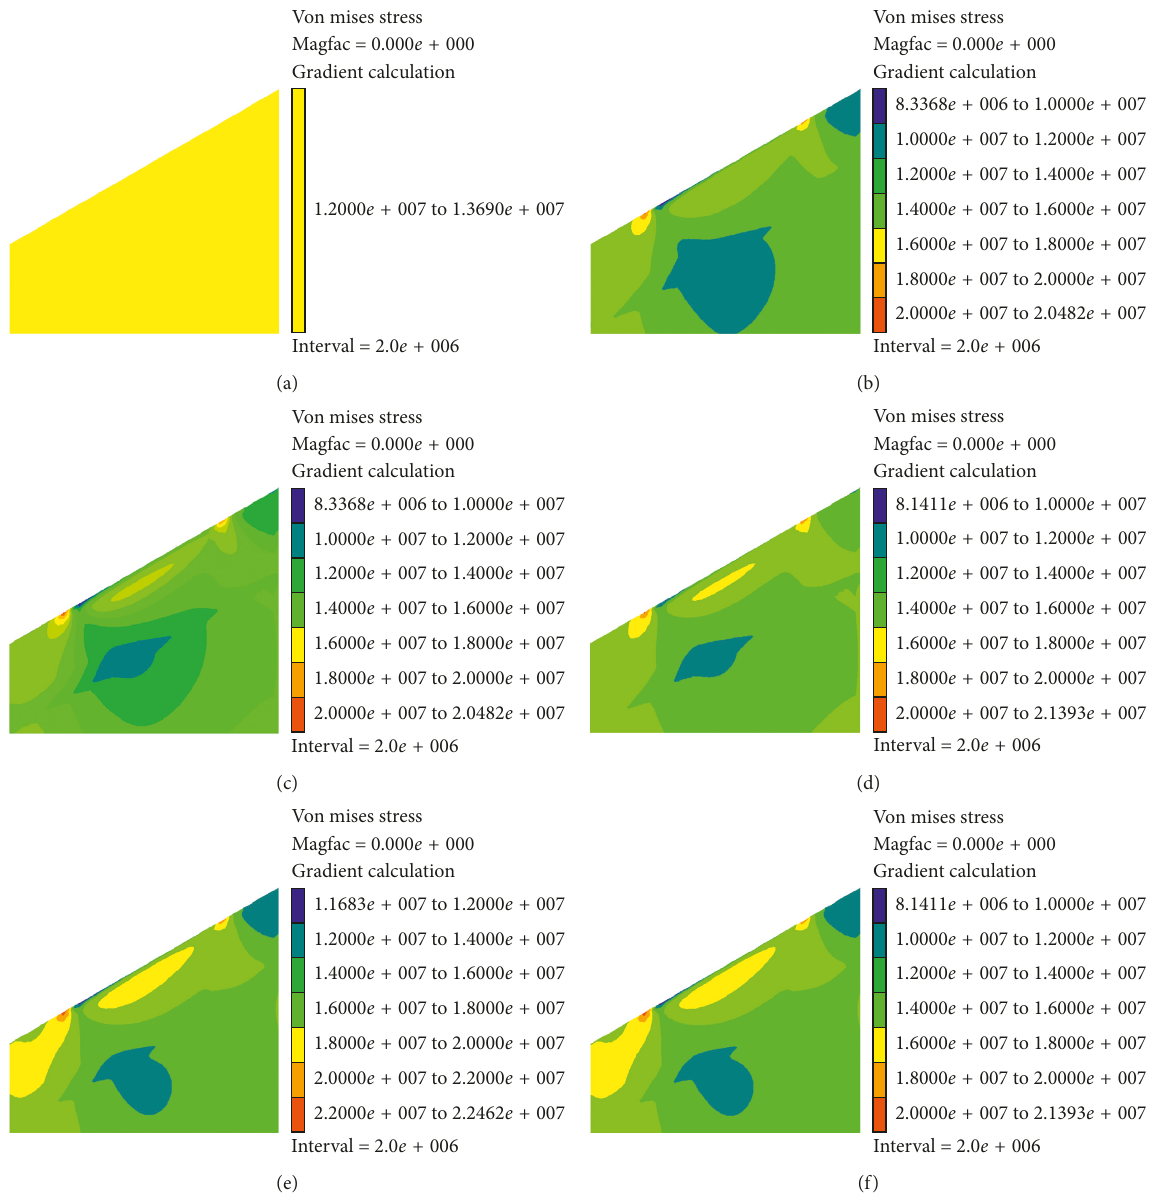
Figure 3: Equivalent stress of workface floor along the inclined direction of the coal seam with the advancement of the workface. (a) Original equivalent stress. (b) Advanced 20m of workface. (c) Advanced 40 m of workface. (d) Advanced 60 m of workface. (e) Advanced 80m of workface. (f) Advanced 100 m of